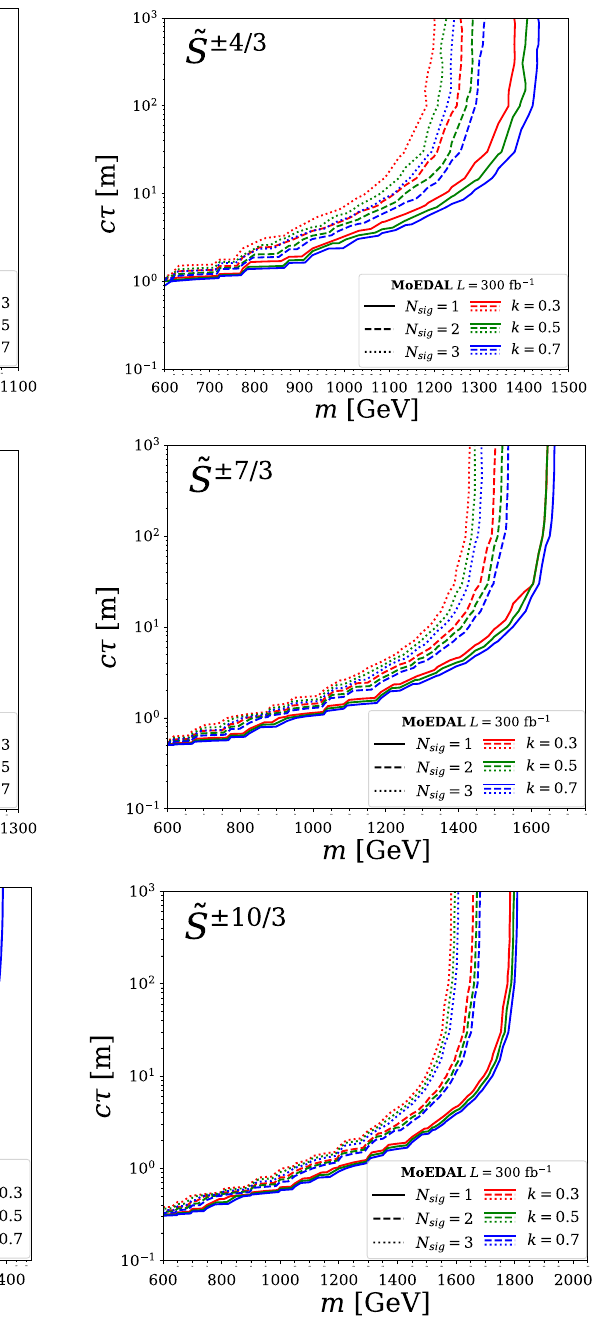
sation parameter k = 0 . 3, 0.5 and 0.7, respectively, and solid dashed and dotted contours represent N sig = 1, 2 and 3, respectively. In the left (right) panel the integrated luminosity of 30 (300) fb − 1 is